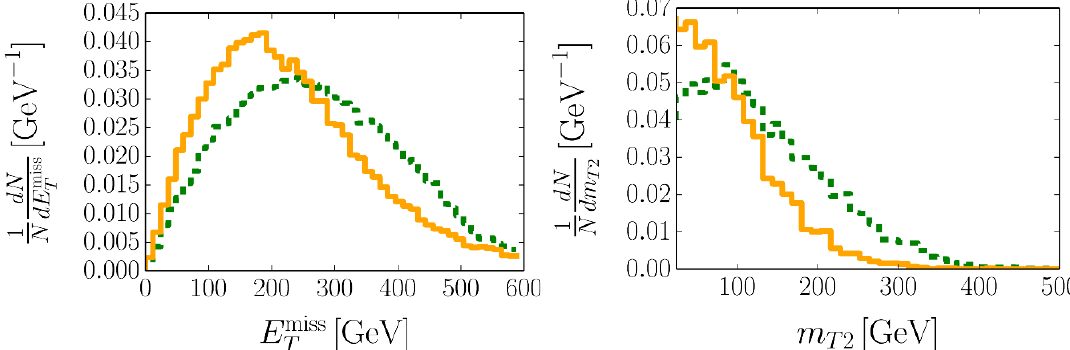
Figure 2 . Left panel: normalized distribution of E miss in the simpli(cid:12)ed model of refs. [39, 40] T (dashed green line) and our scenario (solid orange line) with BR( e t ! t (cid:23)(cid:23) ) = 1. In both cases, e m = 625 GeV and m LSP = 200 GeV. Right panel: normalized distribution of m T 2 in the stop decay e t of the simpli(cid:12)ed model in ref. [41] (dashed green line) and of our scenario when BR( e t ! b (cid:23)(cid:28) ) = 1 e (solid orange line), with m = 700 GeV and m = m = 400 GeV in both e t e (cid:28) e (cid:23)